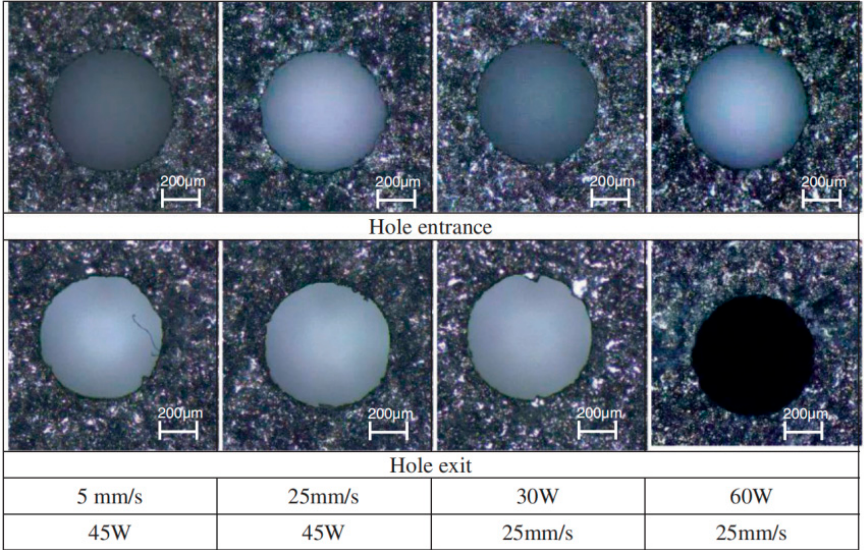
Figure 5. Optical microscopic image showing the hole entrance and exit for various trepanning speeds and power during water-guided laser drilling. Reprinted from [23], with permission from SAGE.